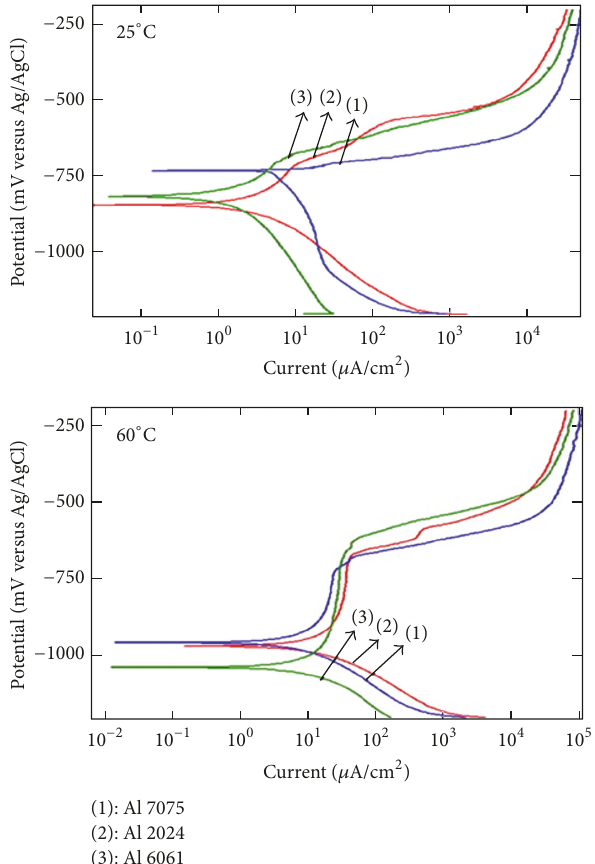
Figure 12: Potentiodynamic polarization curves of Al alloys in the Red Sea water at 25 ∘ C and 60 ∘ C